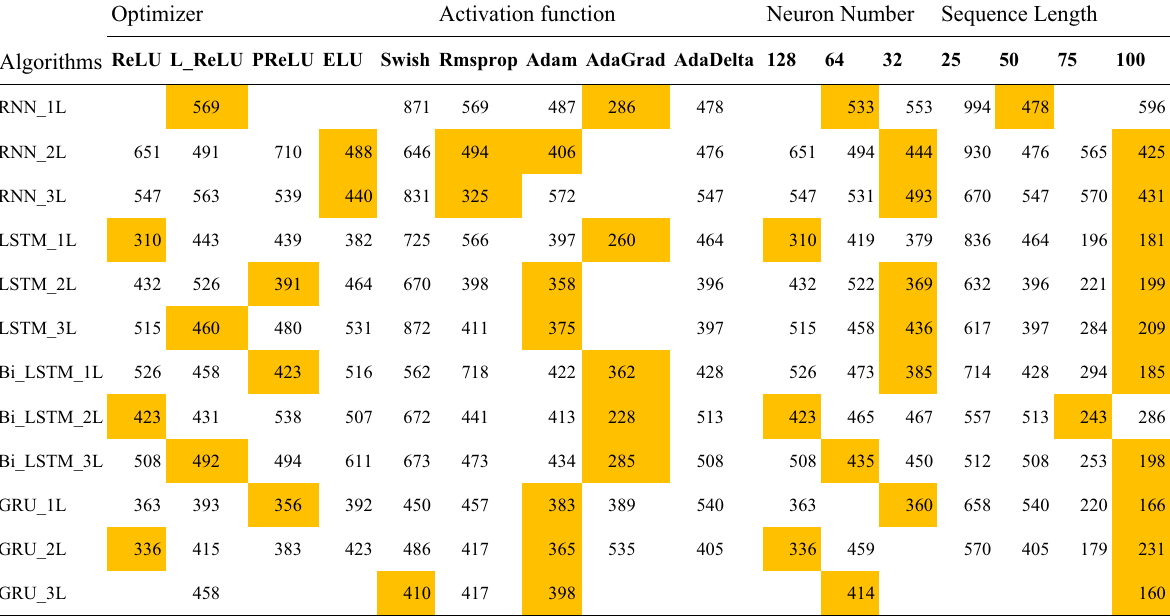
Table 7 The average MSE recorded with regards to different parameters Optimizer Activation function Neuron Number Sequence Length